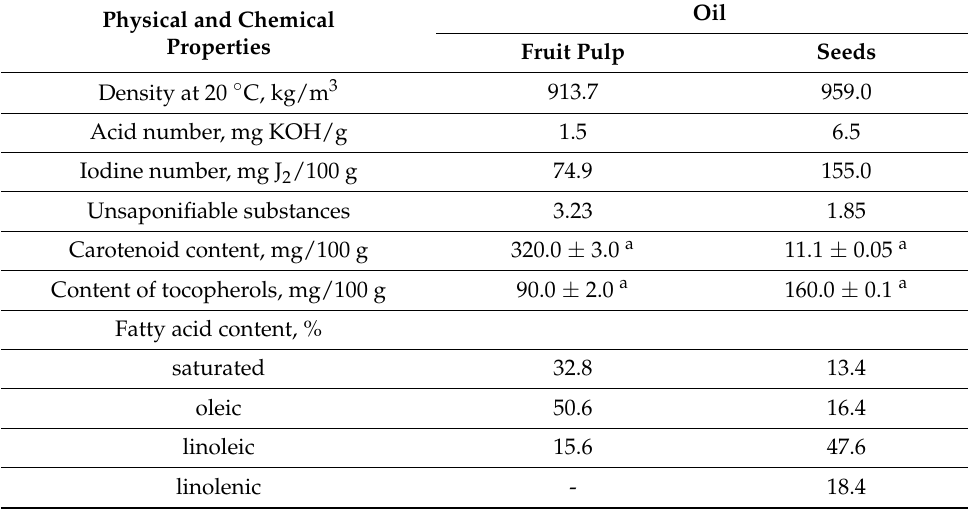
Table 4. Physical and chemical properties of the sea buckthorn